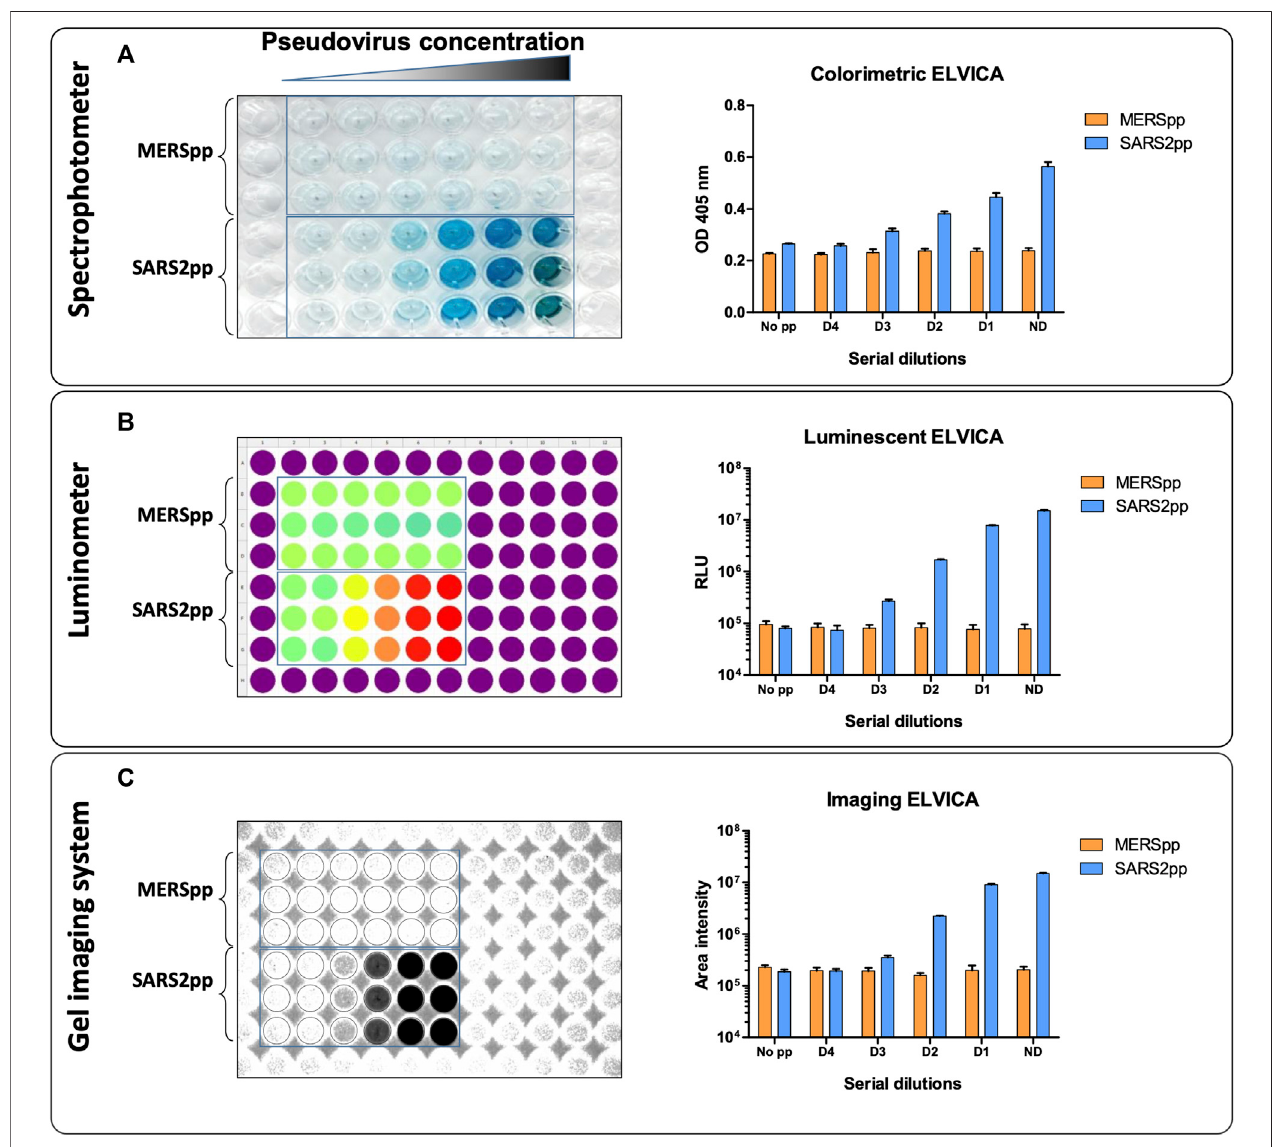
FIGURE2| DetectionofSARSppandMERSppinELVICA.Colorimetric (A) andluminescent (B,C) detectionusingaspectrophotometer (A) ,luminometer (B) ,and digital gel imaging system (C) for the detection of SARS-CoV-2 pseudoviral particles (SARS2pp). MERSpp was used as a negative control.